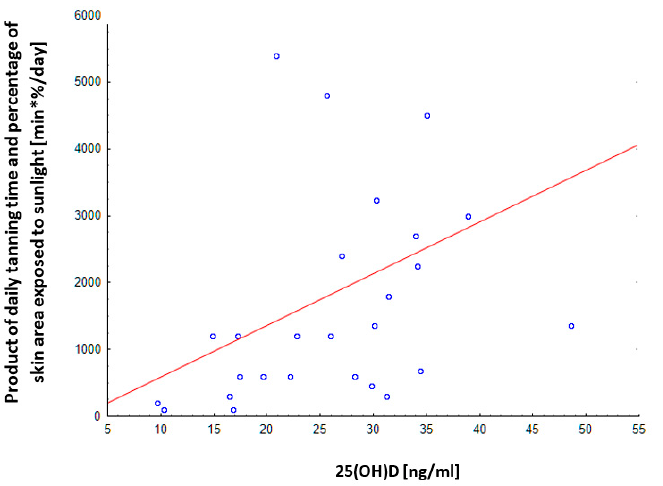
Figure 6. Correlation of the product of the declared tanning time and the percentage of the skin area exposed to sunlight with the concentration of vitamin D determined in the summer period in all surveyed people without vitamin D supplementation. n = 27, Pearson’s R = 0.584, p = 0.0014.